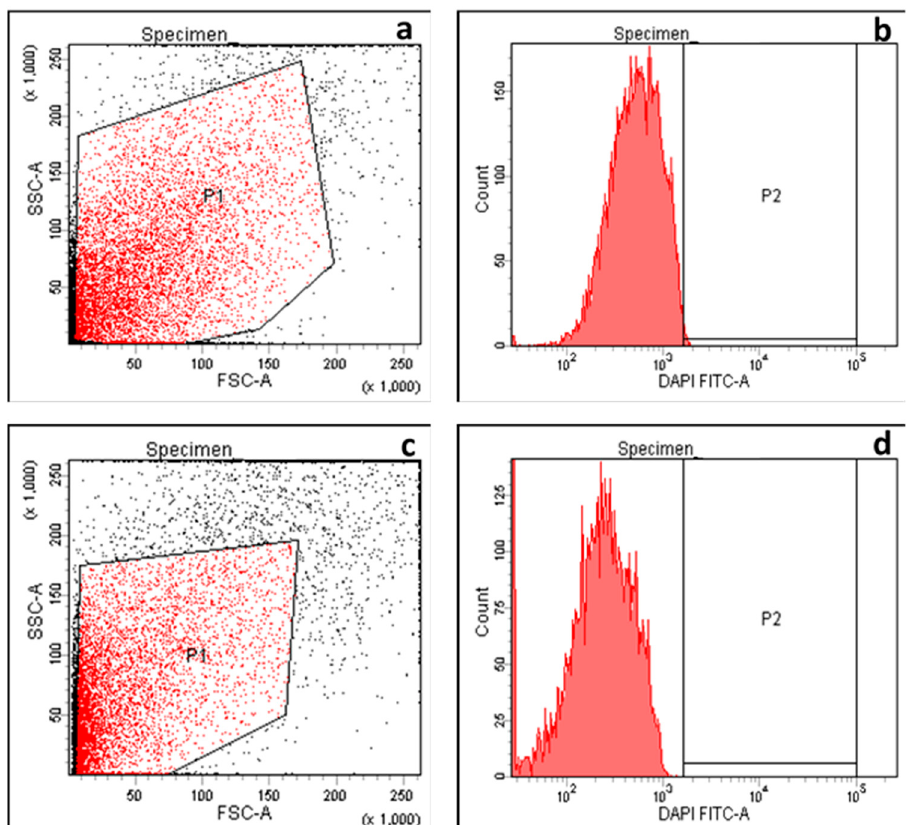
Figure 6. Flow cytometric dot plot and histogram showing fluorescence detected by a FACSverse flow cytometer in a representative K. pneumoniae isolate before treatment (dot plot ( a ) and histogram ( b )) and after treatment (dot plot ( c ) and histogram ( d )) with C. thouarsii extract (16 µg/mL).